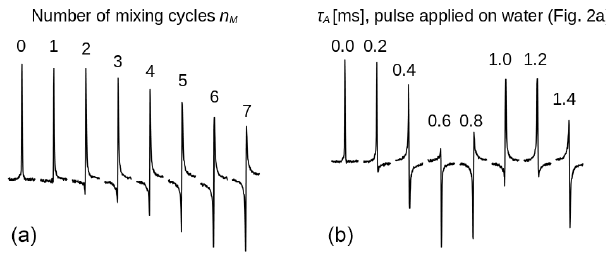
Figure 3. Spectra of the protons of the three methyl groups of DSS obtained with the experiment shown in Fig. 2 with the carrier set at the methyl resonance frequency (conditions before mixing as in Fig. 2d). The selective π/ 2 pulse had a Gaussian profile of 5ms. The strength of the RF amplitude during mixing was 4.17kHz. (a) As the number of cycles n M increases, the signal changes phase. Each pulse train cycle takes about 7ms to complete. After 26 cycles, the resonance is back close to its initial phase (corresponding to a pre- cession frequency close to 5.5Hz). (b) The amount of z magnetiza- tion of H 2 O is varied by applying a rectangular pulse with 250Hz amplitude and a length τ A (marked on top of each spectrum) to the water resonance followed by a pulsed field gradient (Fig. 2a) im- mediately before the sequence with n M = 26. All spectra have the same phase